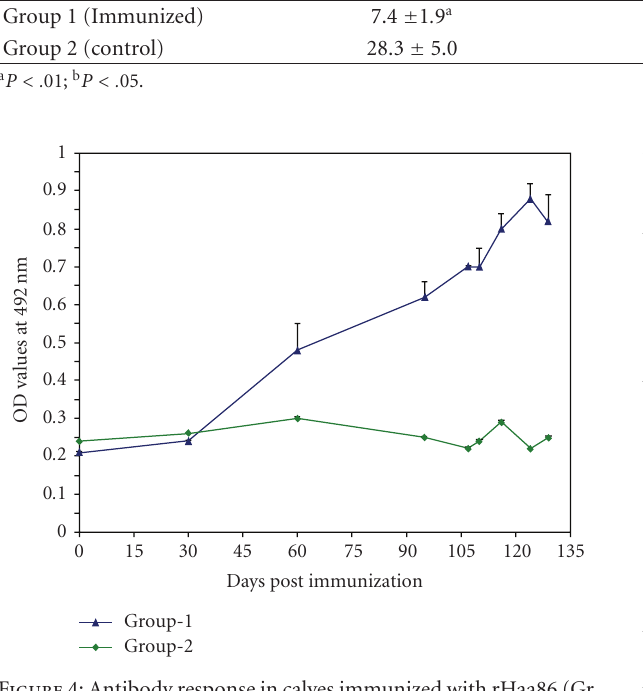
Figure 4: Antibody response in calves immunized with rHaa86 (Gr. 1) and control animals (Gr.